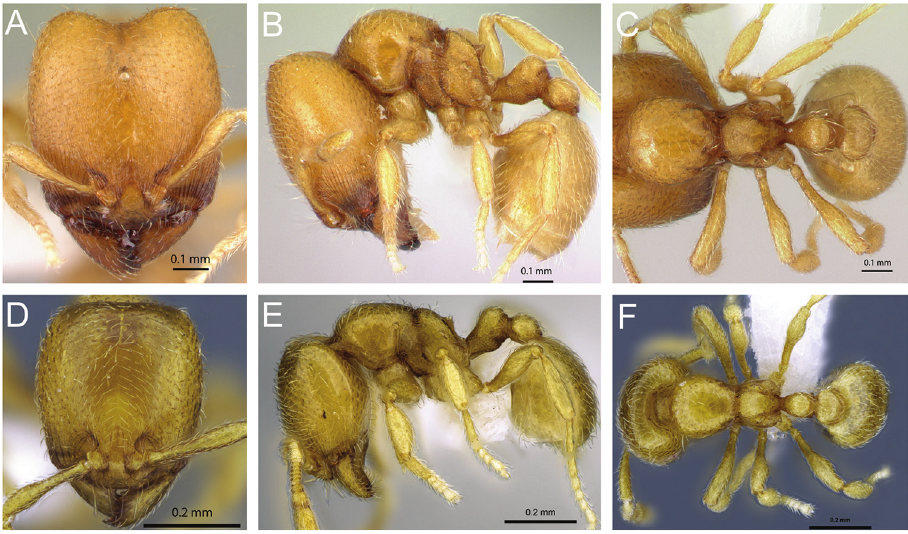
Figure 49. Carebara mahafaly –holotype. Major worker, CASENT0410500: A head in full-face view B body in profile view C body in dorsal view. Minor worker, CASENT0410535: D head in full-face view E body in profile view F body in dorsal